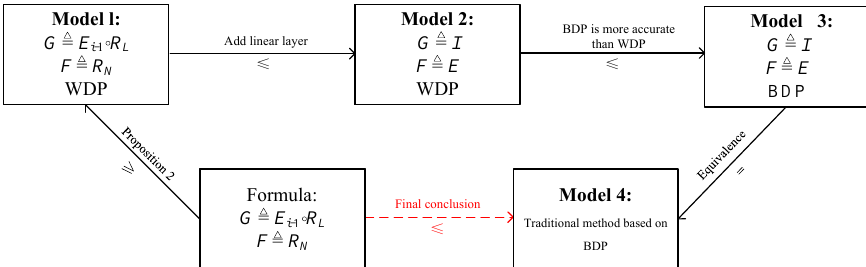
Figure 1: The relationship of these four models and Boura and Canteaut’s formula. In this diagram, A ≤ B means the value of the upper bound derived by B is less than or equal to that of B